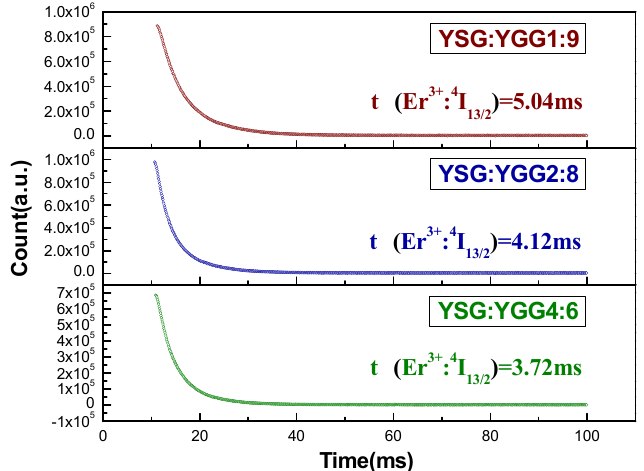
Figure 8. Decay curves of Er 3+ : 4 I 13/2 levels in samples of YSG:YGG 1:9, 2:8 and 4:6.